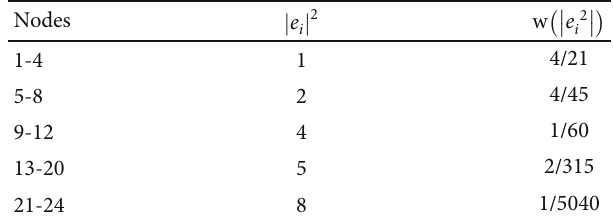
j 2 Þ of the E8 model used in the current modeling Table 1: The w ðj e i study.